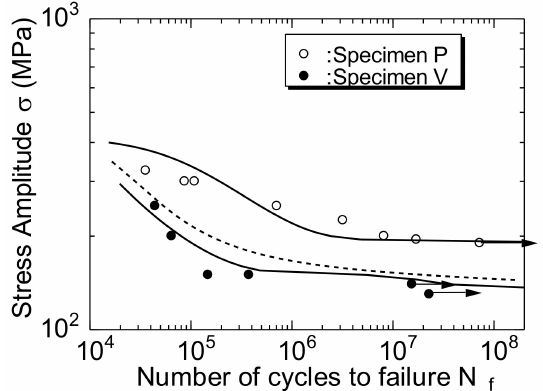
Figure 12. Comparison of S–N curve calculation results and experimental results. The solid lines in the figure are the S–N curves calculated for specimens P and V using Equation